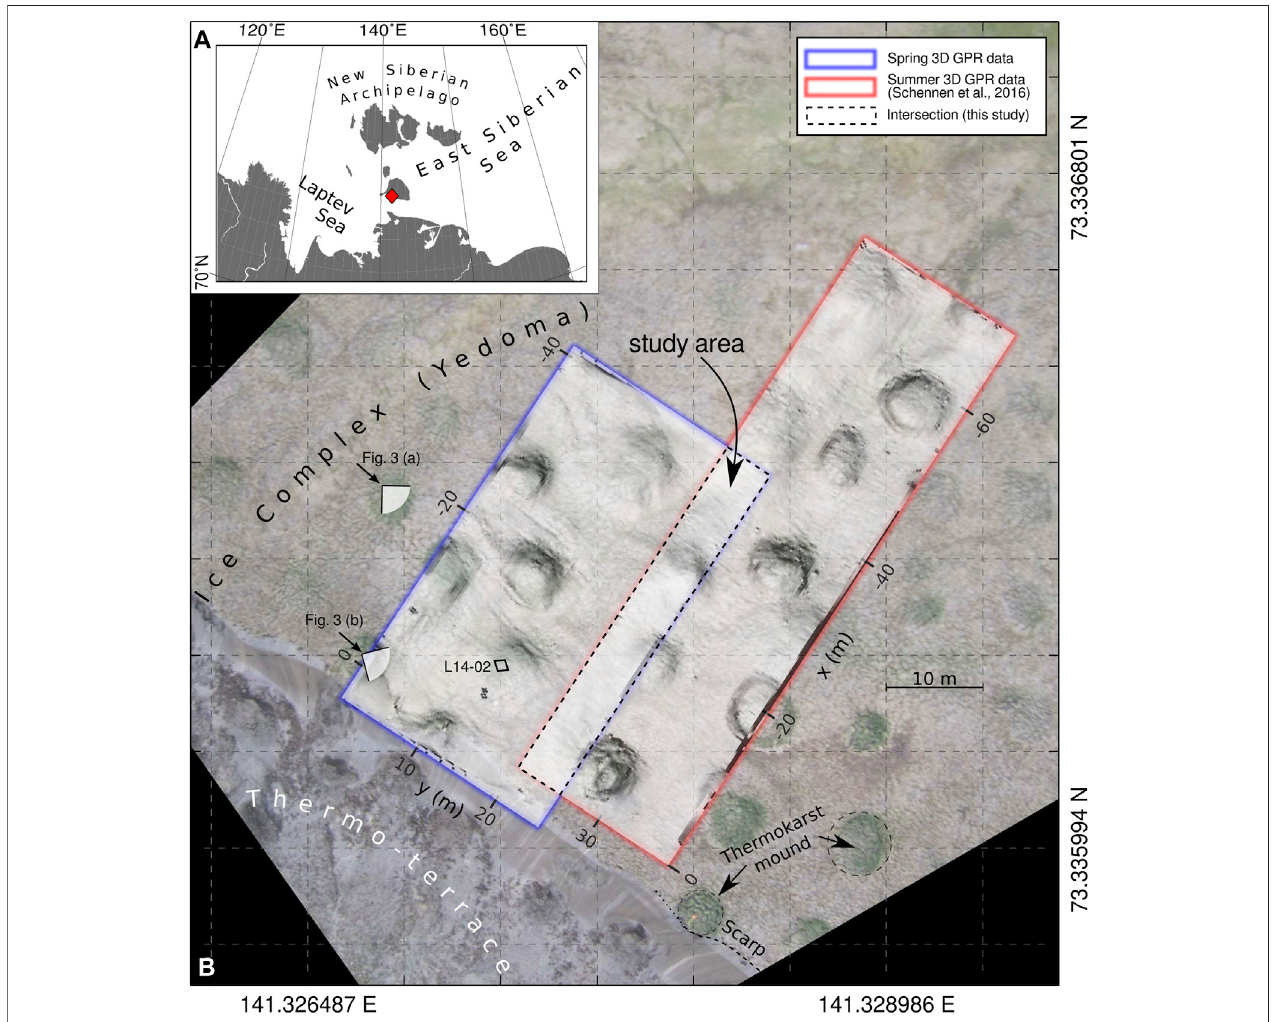
FIGURE 1 | GPR survey site showing (A) the location of the study area on Bol ’ shoy Lyakhovsky Island and (B) an aerial orthophoto of the fi eld site with an overlain transparent hillshade-like visualization of the digital terrain model. The dashed rectangle denotes the study area; i.e., the area where GPR data have been recorded in spring and summer 2014. The coring site L14-02 ( Supplementary Table S1 ) is located inside the area covered by our spring GPR survey. The general elevation slope from SW to NE is − 10%.